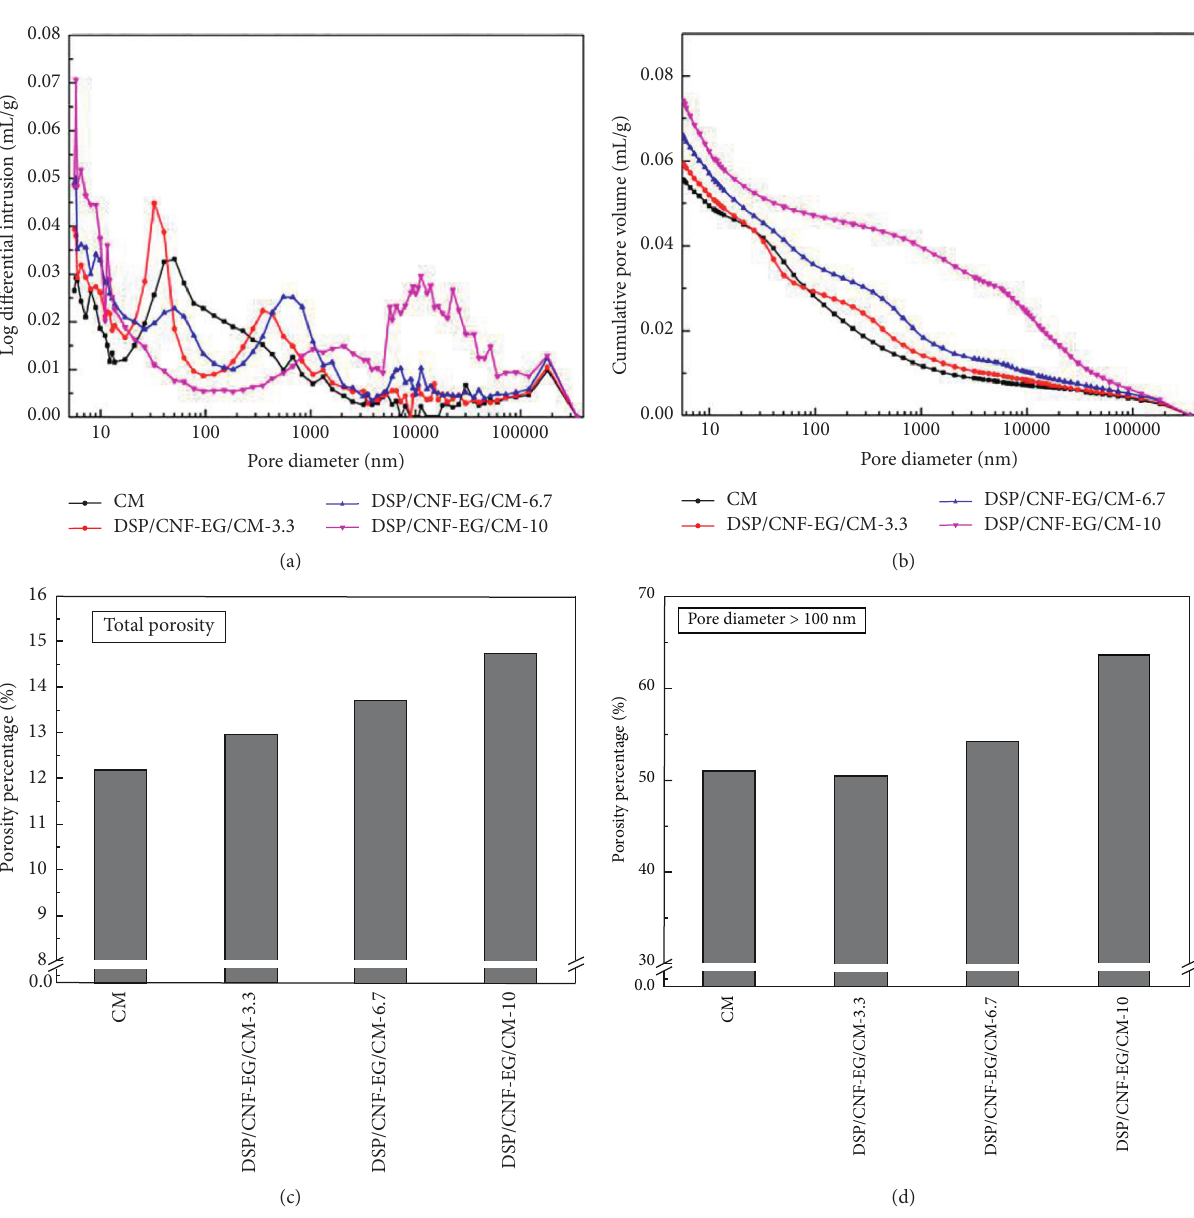
Figure 3: Pore structure analysis of CM, DSP/CNF-EG/CM-3.3, DSP/CNF-EG/CM-6.7, and DSP/CNF-EG/CM-10: (a) pore diameter distribution, (b) cumulative pore volume, (c) total porosity, and (d) the proportion of pores greater than 100nm in the total